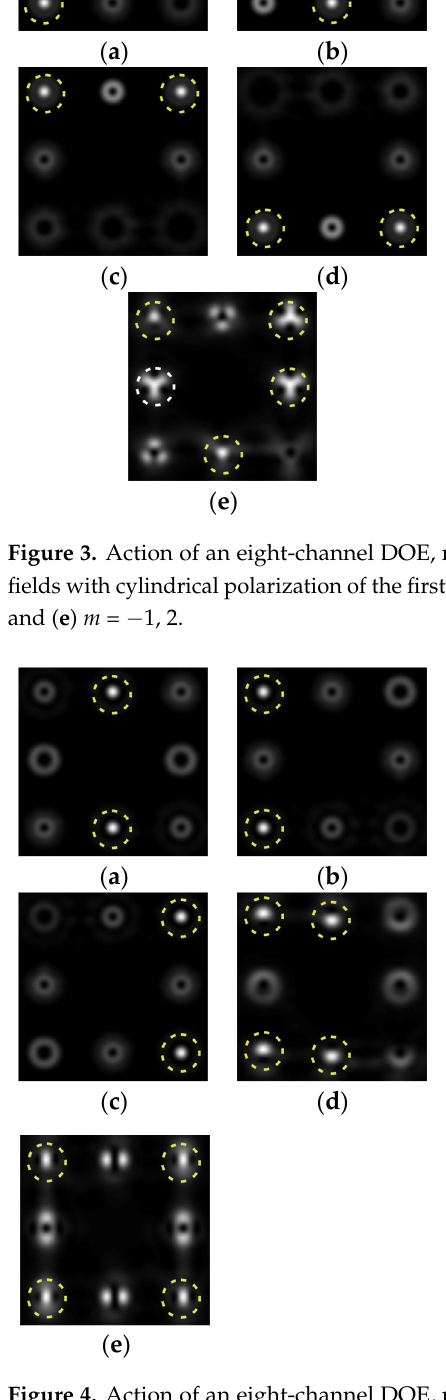
Figure 4. Action of an eight-channel DOE, matched with optical vortices in the analysis of vortex fields with cylindrical polarization of the second order ( p = 2): ( a ) m = 0, ( b ) m = 1, ( c ) m = − 1, ( d ) m = 0, 1, and ( e ) m = − 1, 1. Table 2. Code correspondence of diffraction order numbers to the presence of phase vortices in the analyzed beam for a cylindrical state of the first order polarization ( p = 1).